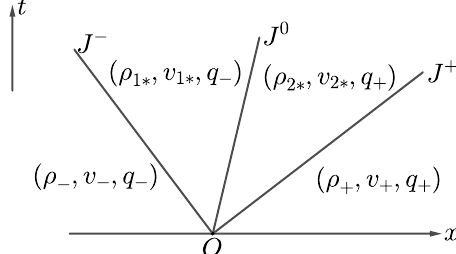
Figure 1: Riemann